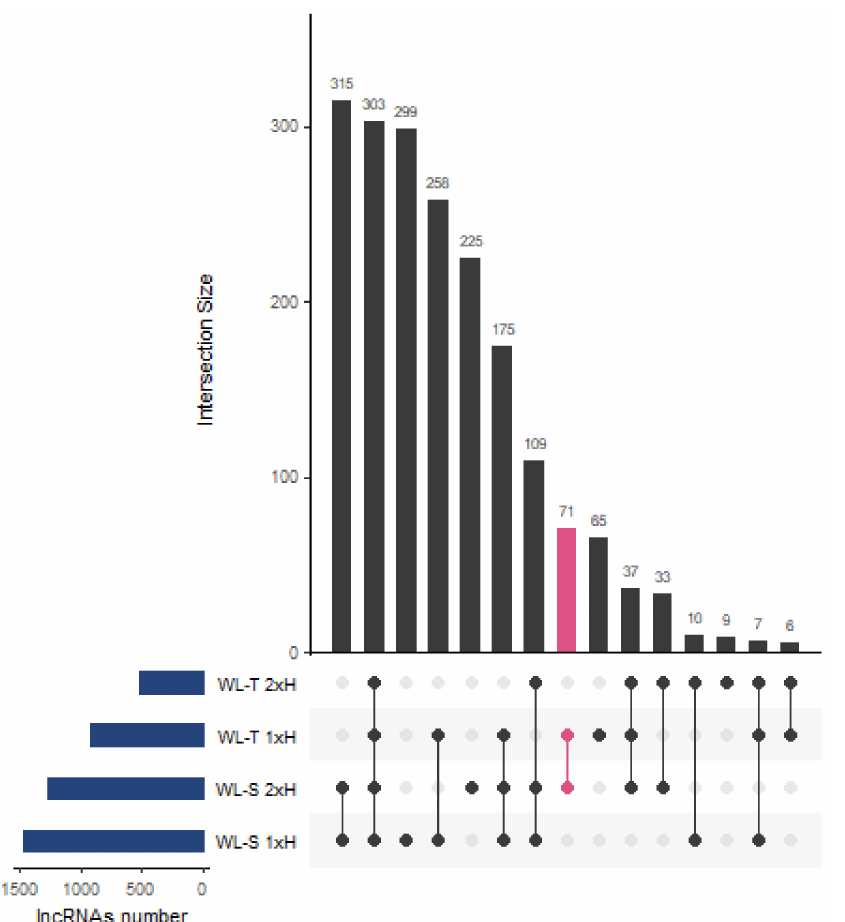
Figure 4. Upset plot presenting number of common and specific DE-lncRNA in four treatment groups in comparison to control conditions, i.e., non-primed (1xH) and primed (2xH) plants in two cucumber accessions, WL-T and WL-S. In pink, number of lncRNAs potentially involved in acquisition of long-term tolerance to waterlogging was